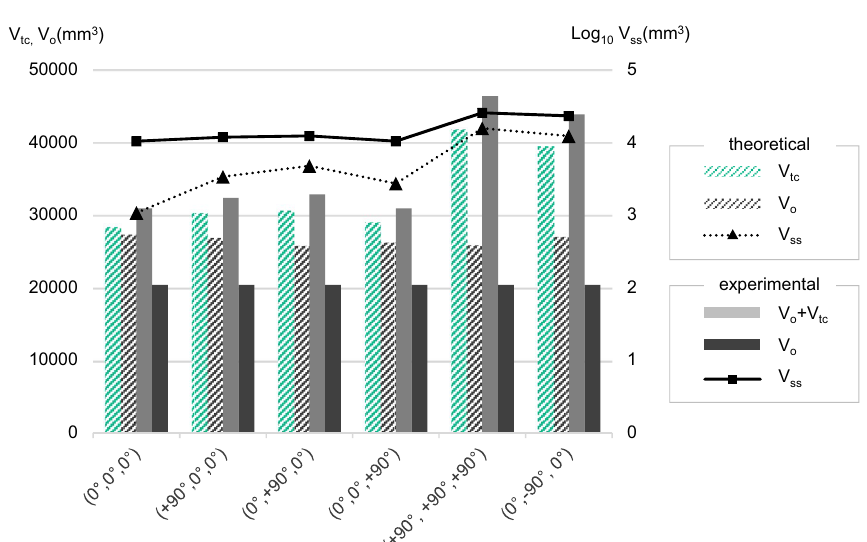
Fig. 6 Comparison of experimental and theoretical amount of support structure for “Stanford Bunny” for the six initial orientation